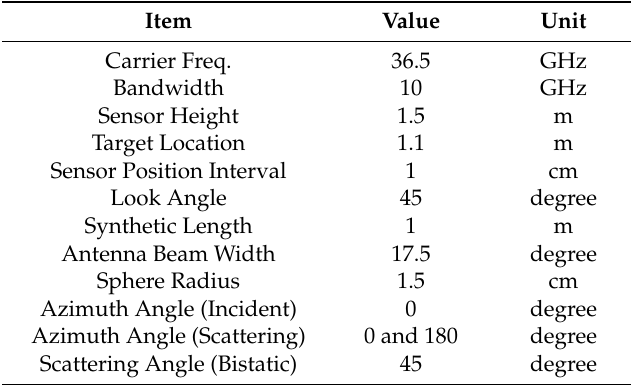
Table 1. Simulation